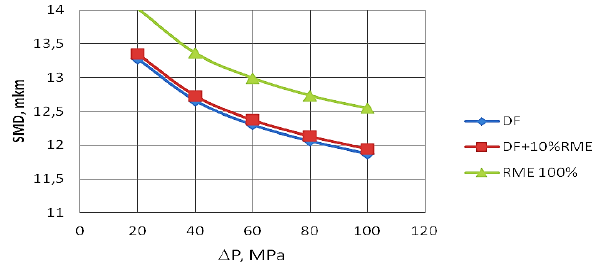
Fig. 2. Change of the average diameter of atomized fuel drop depending on the injected fuel